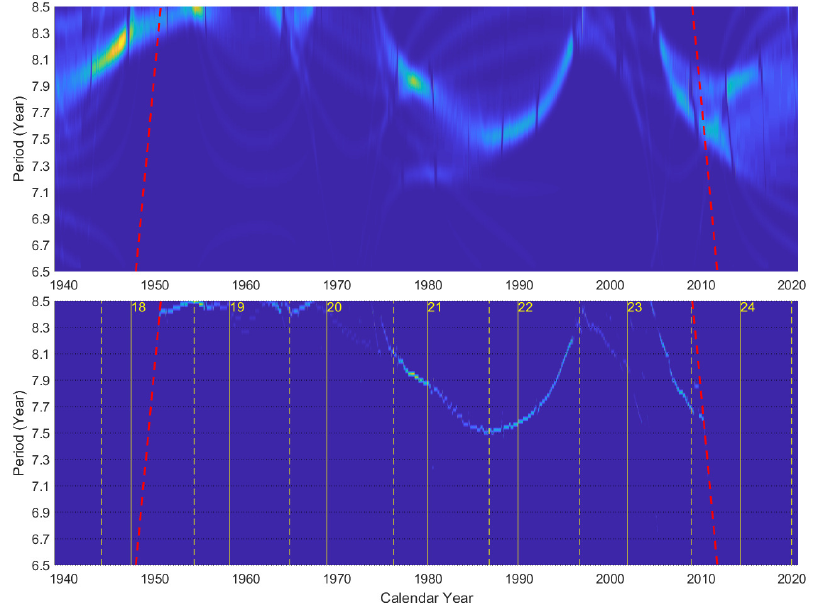
Figure 7. Same as Figure 6, but for periods between 6.5 and